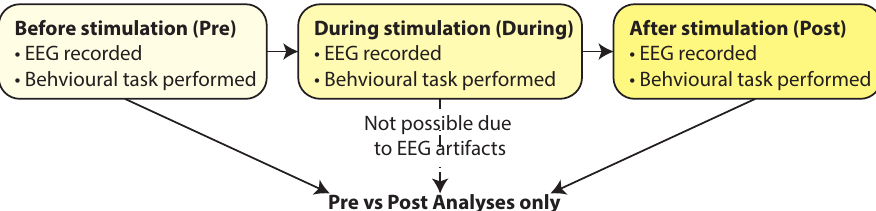
Figure 1. Most combined EEG+tES experimental protocols use only a comparison of EEG data before and after the stimulation due to the presence of stimulation artifacts in the EEG trace during stimulation. Figure originally reported in [12] (with copyright permission from